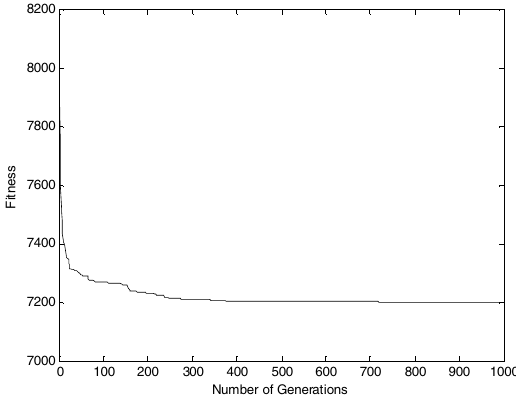
Fig. 6. Convergence procedure of hybrid optimization algorithm in pressure vessel